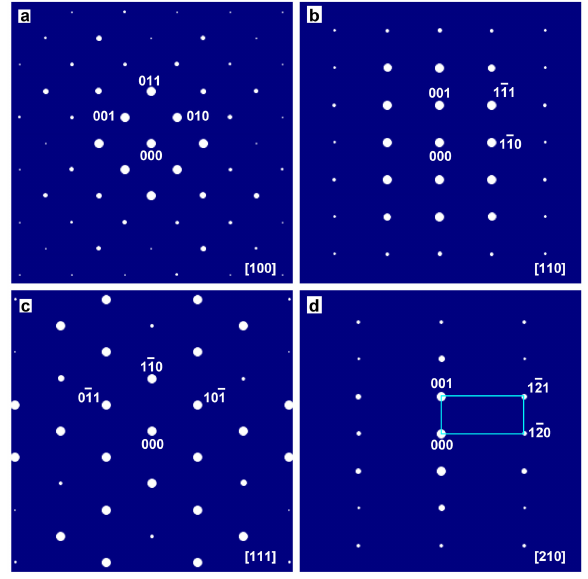
Figure 13: Calculated electron diffraction patterns of cubic